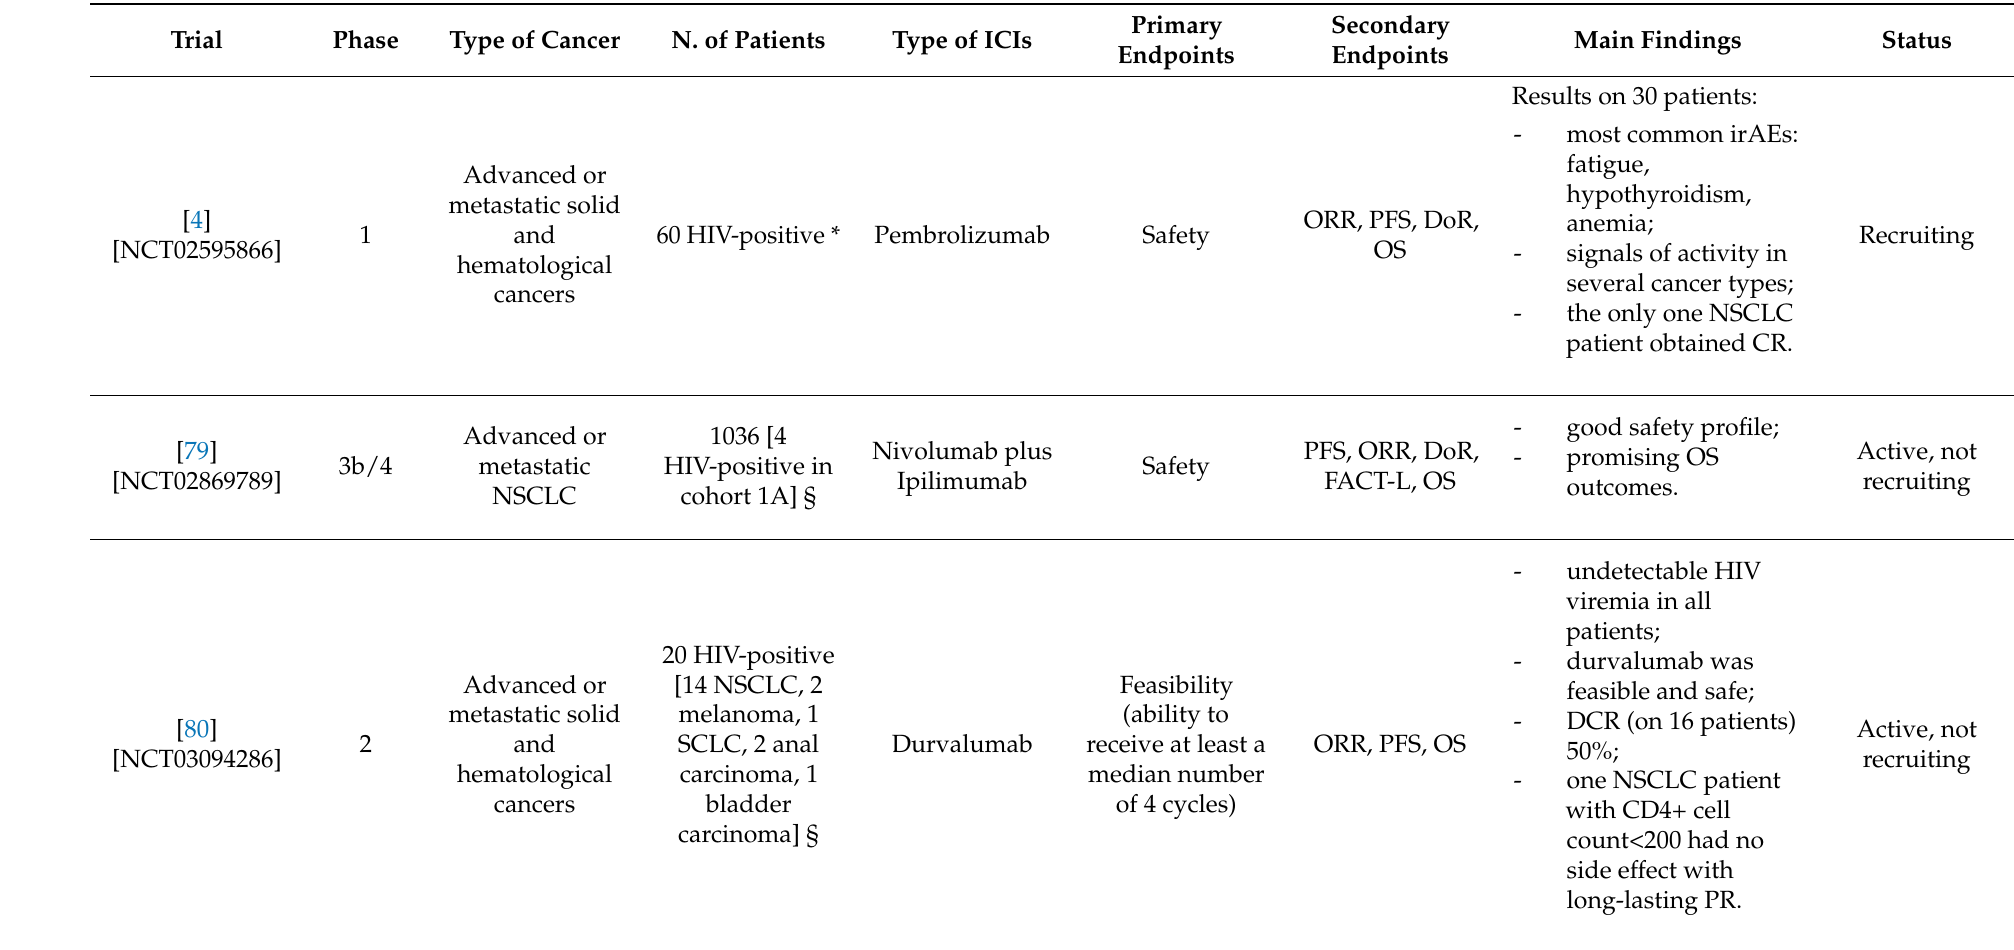
Table 2. Clinical studies investigating safety and efficacy of ICIs in HIV patients affected by solid tumors, including lung